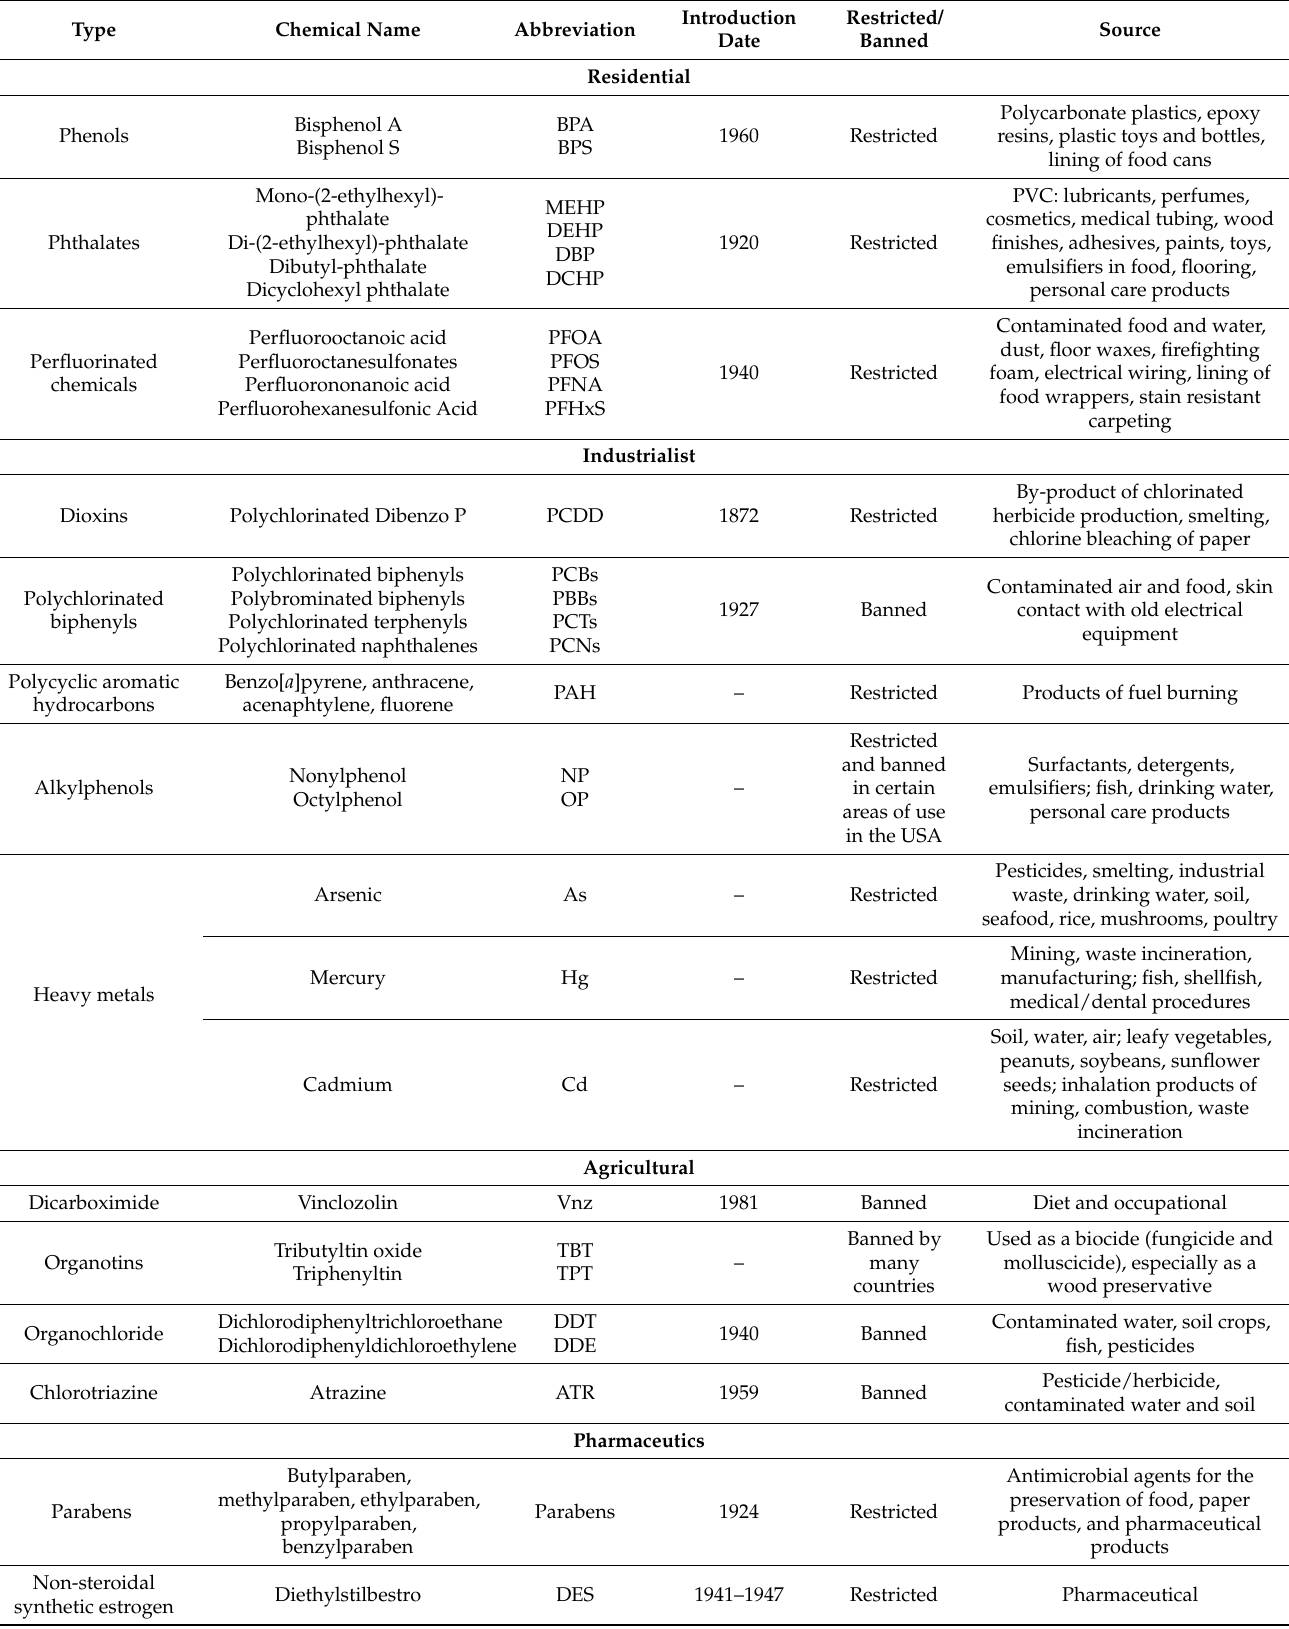
Table 1. Origin-based classification of main endocrine-disrupting chemicals